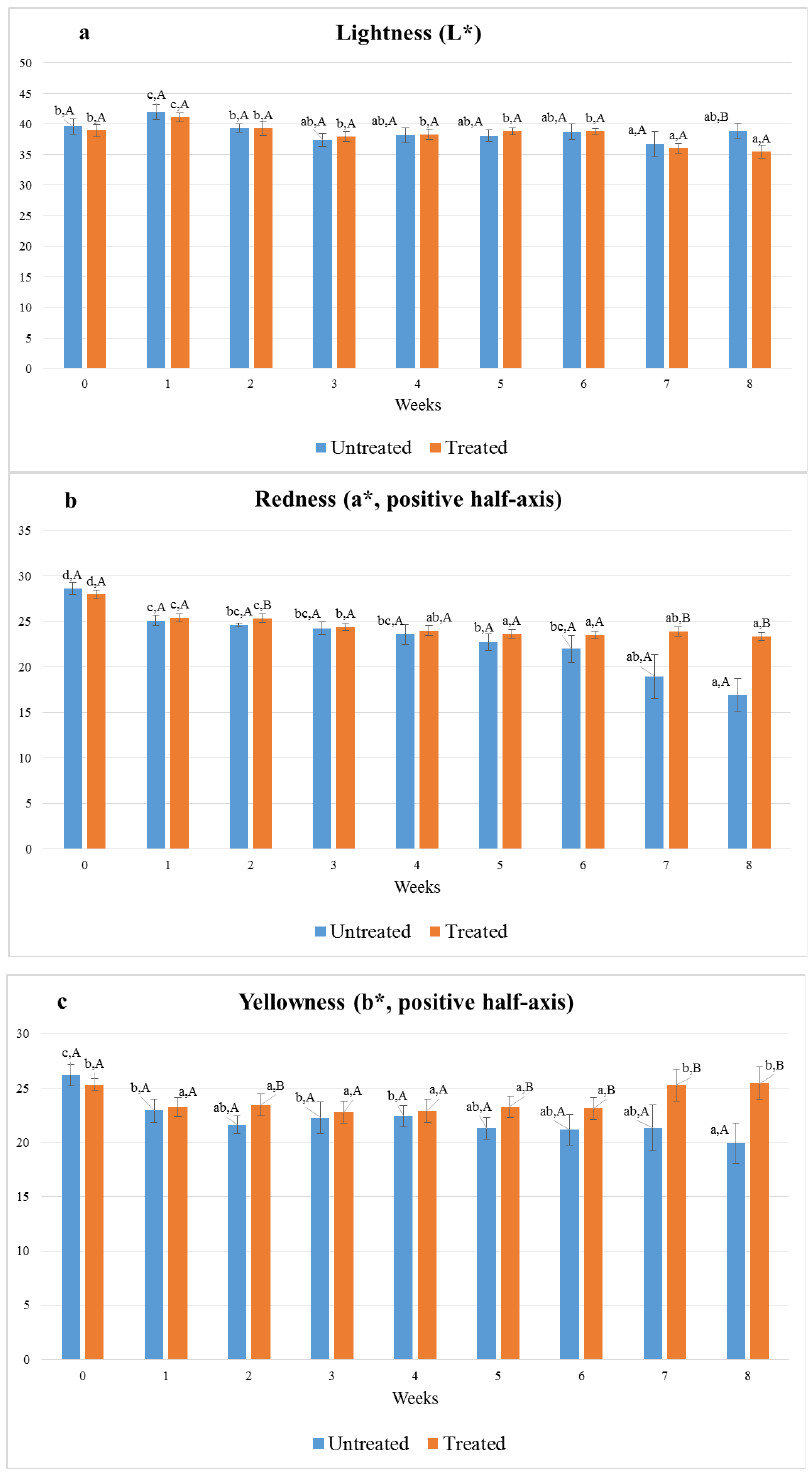
Figure 3. The effect of treatment with thymol on color coordinates. The means of lightness (L*), ( a ) redness (a*) ( b ) and yellowness (b*) ( c ) values of sausages refrigerated at 6 °C for eight weeks. Lowercase superscript letters show the effects of time. Capital letter superscripts show the effects of treatment. Means sharing common superscripts did not differ significantly ( p > 0.05). The measured values for the red – green color coordinate (a*) fell on the positive semi- axis; consequently, their absolute values were attributable to the redness of the color. The redness of the surface of the salami slices decreased as a function of cold storage duration (Figure 3b), but the decrease in a* was more pronounced for the untreated samples. Dur- ing the seventh and eighth weeks of storage, the surface a* values of the thymol-treated samples were significantly greater than those of the untreated samples at the respective sampling timepoints. The values of the yellow – blue color coordinate (b*) fell on the positive semi-axis; con- sequently, their absolute values were proportional to the yellowness of the color. As de- picted in Figure 3c, the yellowness of the untreated samples decreased overall as com- pared to the treated samples. From the fifth week of storage until the end of it, the surface b* values of the treated samples were significantly higher than those of the untreated sam- ples. Figure 4 depicts an experimental unit, a box with four slices of salami, at the begin- ning of storage (Figure 4a) and after eight weeks of refrigerated storage (Figure 4b). Sep- arated by a net, the box contained two slices of salami treated with thymol and two slices of untreated salami. The top two slices in the image were treated with thymol, while the bottom two were untreated. At the beginning (Figure 4a) and end of storage (Figure 4b), the colors of the thymol-treated slices were nearly identical, whereas significant portions of the surfaces of the untreated slices were discolored.